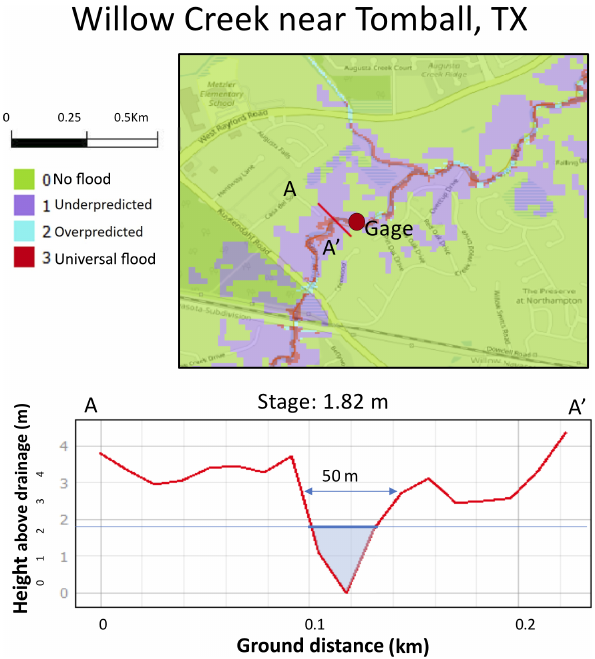
Figure 6. Inaccurate synthetic rating curve relationship causes un- derprediction in a 2nd-order